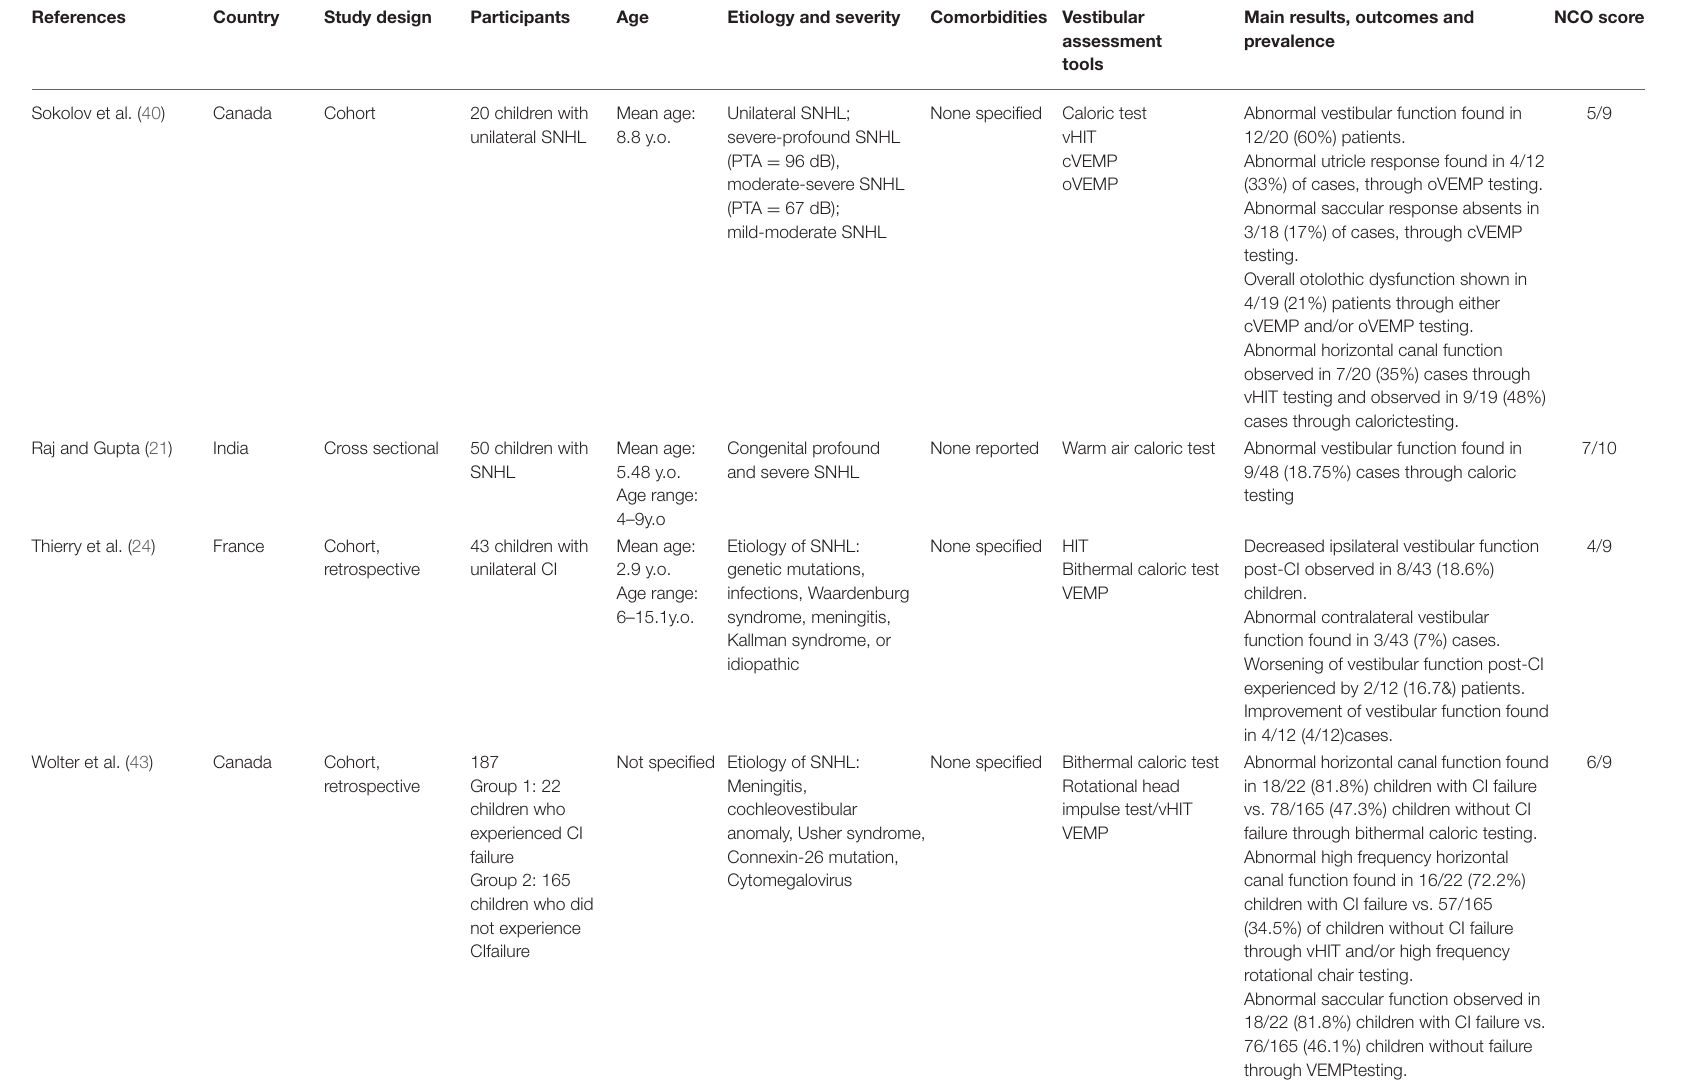
TABLE 2 | Studies addressing central neurological conditions (Sensorineural hearing loss and cochlear